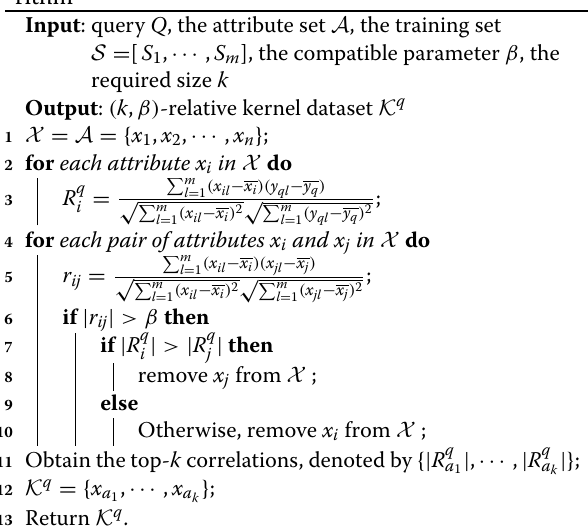
Algorithm 1: Relative Kernel Dataset Retrieving Algo-